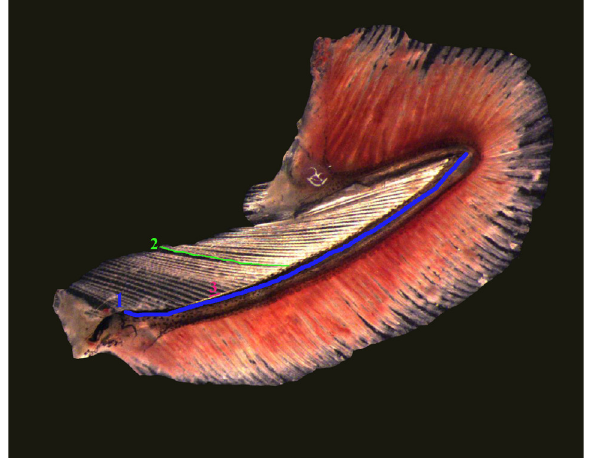
Fig. 2. – Photo of the first left branchial arch of a sardine adult, indicating how the different structures were measured: 1, length of ceratohypobranchial arch (blue line); 2, length of a central gill raker (green line); 3, space between two consecutive gill rakers, at their bases (pink